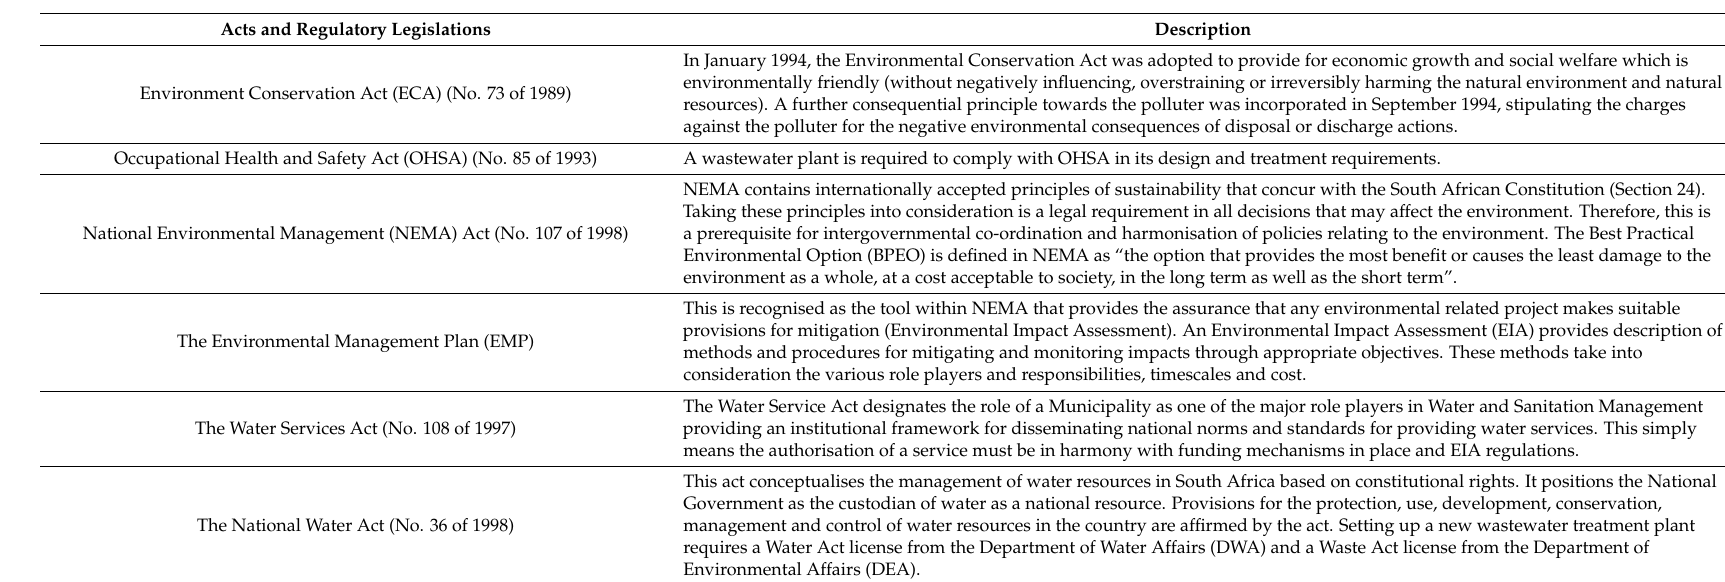
Table 3. South African wastewater regulatory